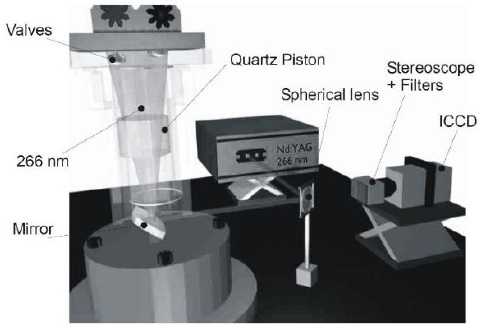
Figure 25. The experimental setup of valve temperature measurement using the ratio method [138]. Reprinted with permission from [138]. SAE International, 2004.